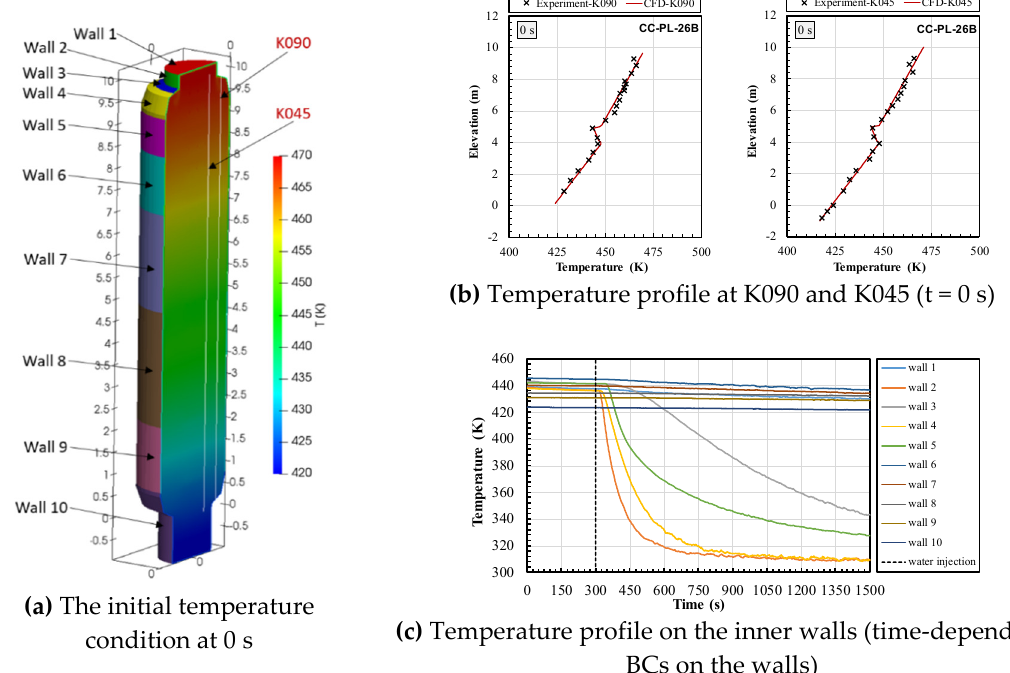
Figure 3. Temperature’s initial condition inside the vessel and the boundary conditions at the walls.